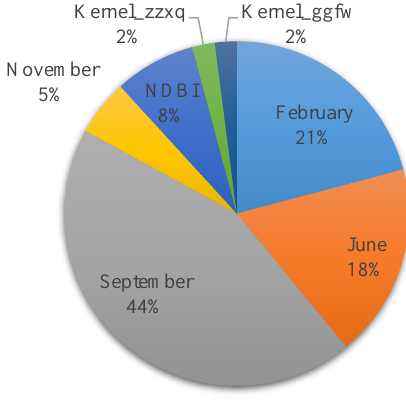
Figure 8. The proportion of the first 31 features.